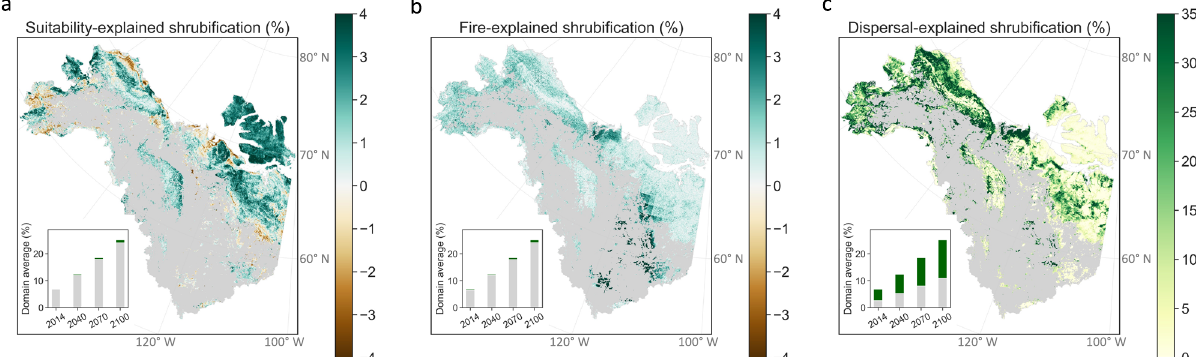
Fig. 4 Shrub expansion over the 21st century was primarily attributed to seed dispersal. Shrub expansion driven by ( a ) environmental suitability change from 2014 to 2100, ( b ) projected fi re, and ( c ) short- and long-distance seed dispersal. The insets show the domain average of shrub expansion from 2014 to 2100; the gray sections show shrub expansion in a scenario where the corresponding factor was turned off and the green sections represent its